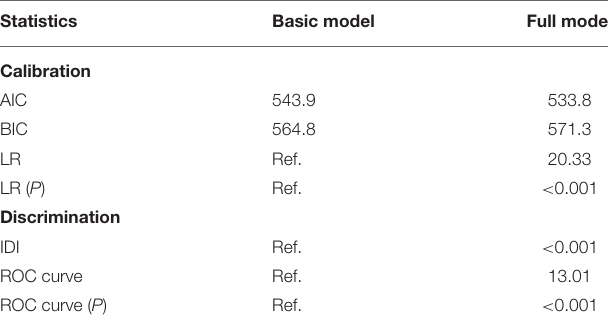
TABLE 2 | Prediction accuracy gained by adding risk factors to basic model for the risk of